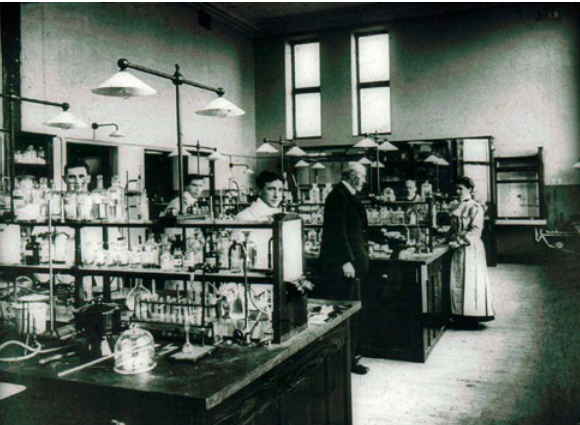
Figure 8. The new chemical research laboratory in St Andrews around 1906. Professor Thomas Purdie is the figure in the black coat. Courtesy of the University of St Andrews Library: ID: 2012-